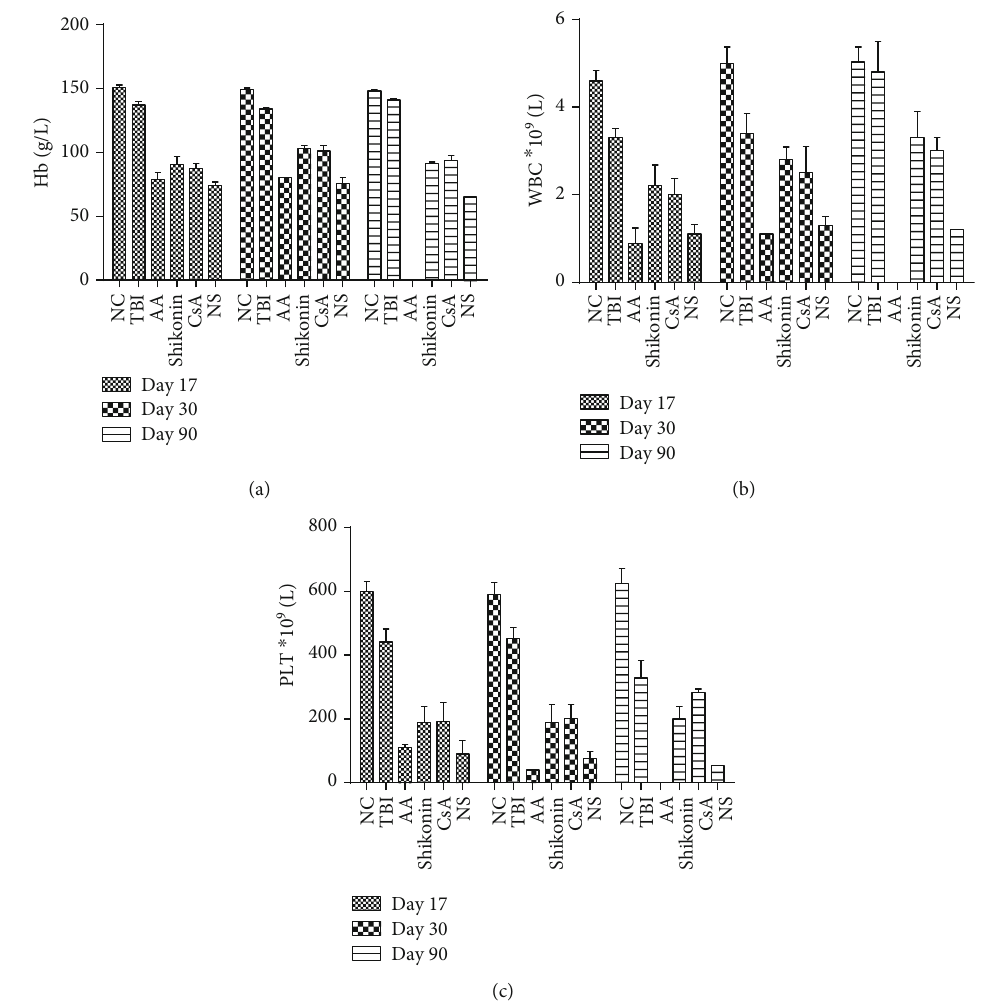
Figure 7: Mice peripheral blood counts at day 17, day 30, and day 90. Until the time of death, no improvement was observed in (a) Hb, (b) WBC, and (c) PLT in the mice from the AA model and NS groups, whereas the blood counts from the shikonin and CsA groups gradually recovered over time, especially leukocytes ( p < 0 : 05 ). AA: aplastic anemia ( n = 17 ); TBI: total body irradiation ( n = 10 ); NC: normal control ( n = 10 ); shikonin ( n = 10 ); CsA: cyclosporin A ( n = 10 ); NS: normal saline ( n = 10